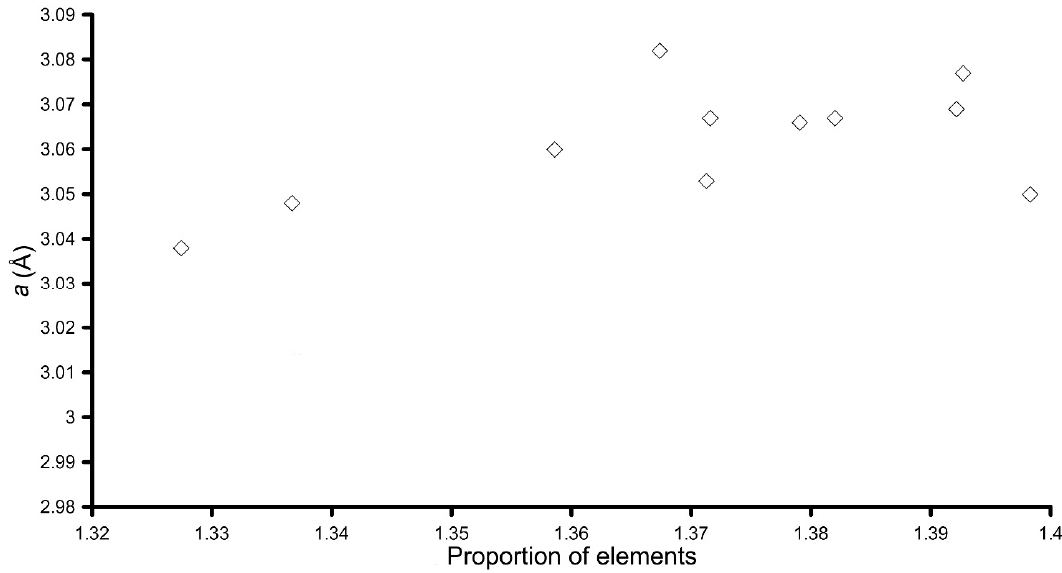
Figure 8. Plot of the proportion of elements vs. a for the LDH synthetic samples.